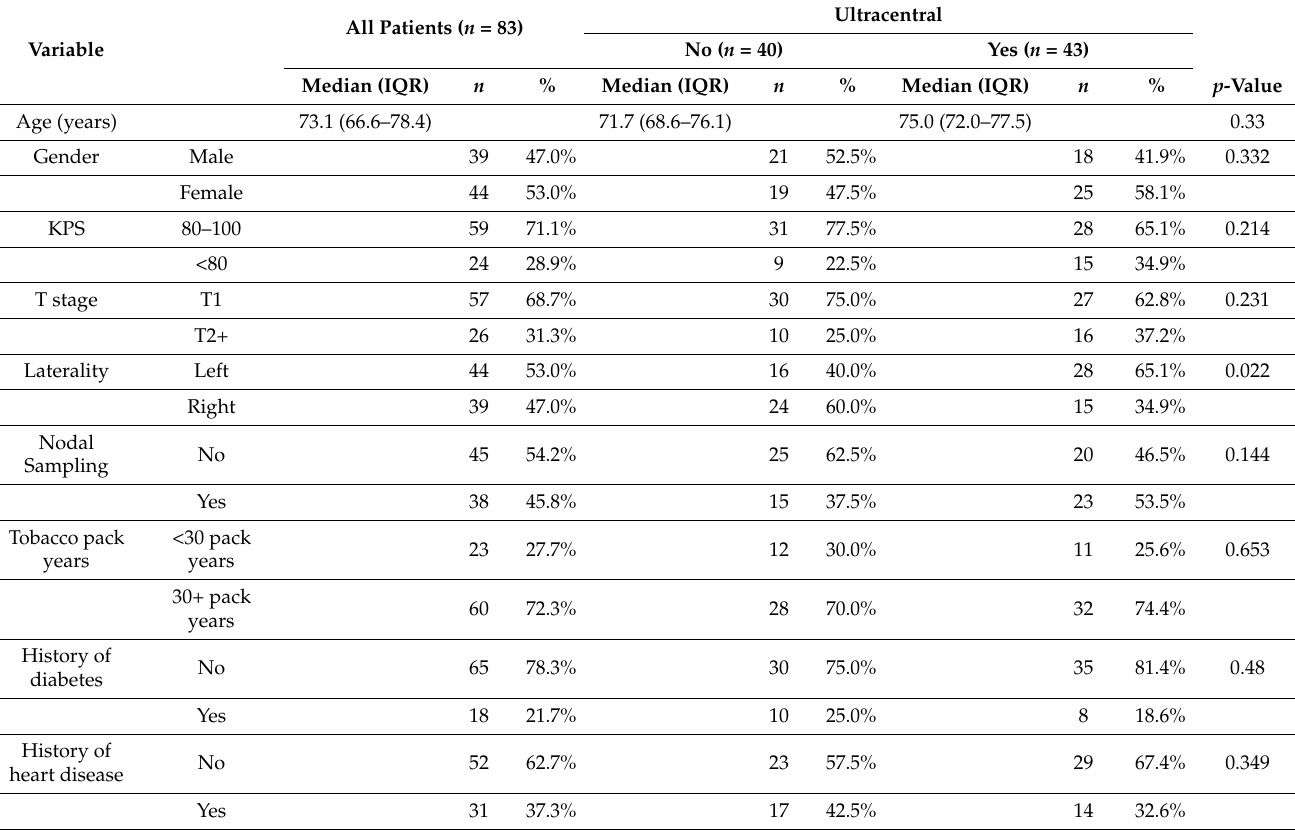
Table 1. Patient